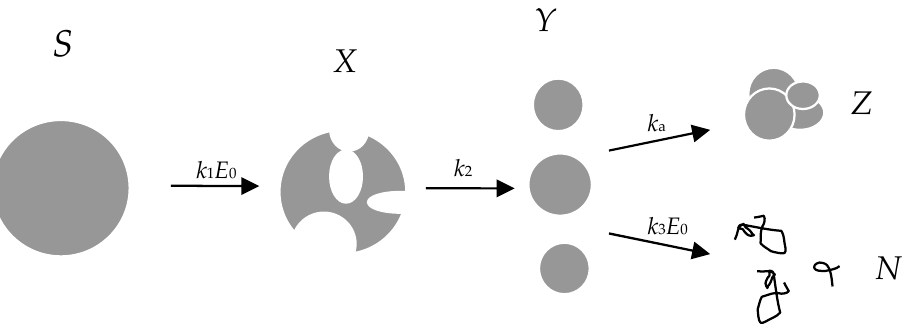
Figure 6. Successive scheme of β -CN proteolysis by trypsin describing rearrangement of peptide nanoparticles.